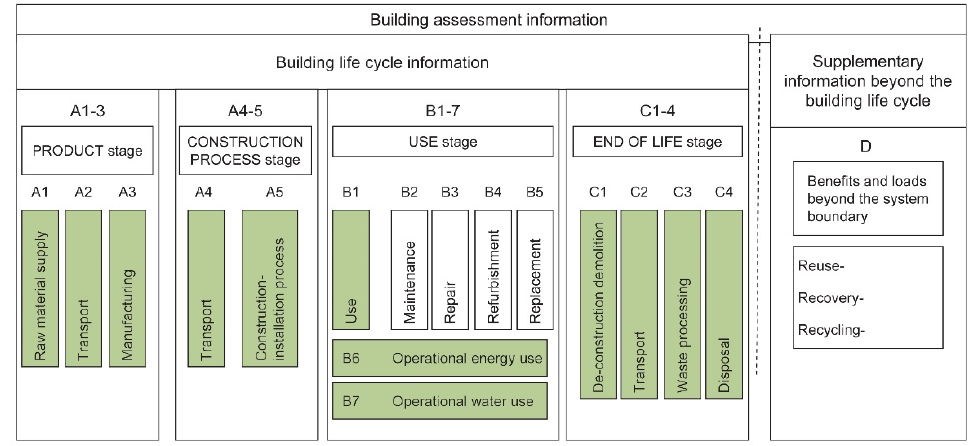
Figure 2. Life cycle phases according to BS EN 15978 [17], phases selected for the LCA assessment, have been highlighted by the author.